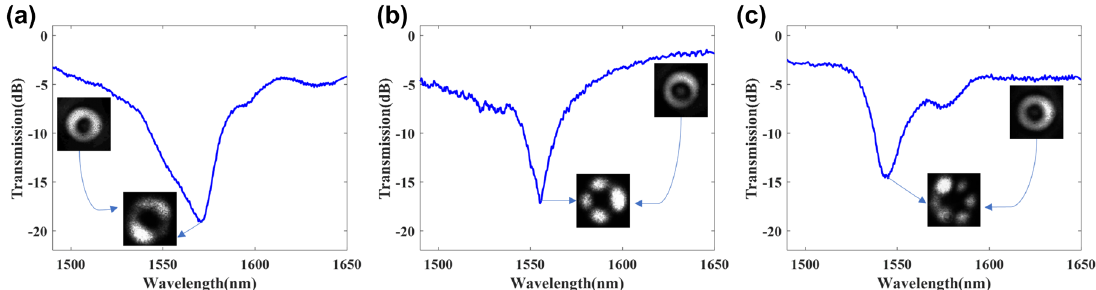
Figure 9: Experimental transmission spectrum of RCF grating for (a) the 1-order, (b) the 2-order and (c) the 3-order.